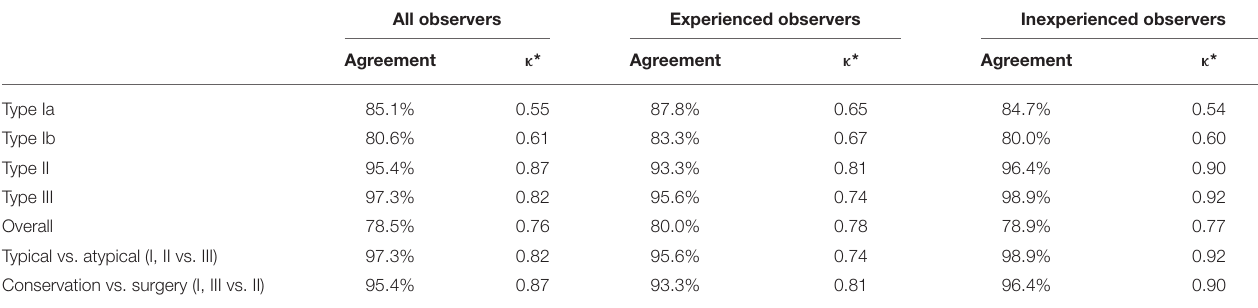
TABLE 2 | Interobserver reproducibility.